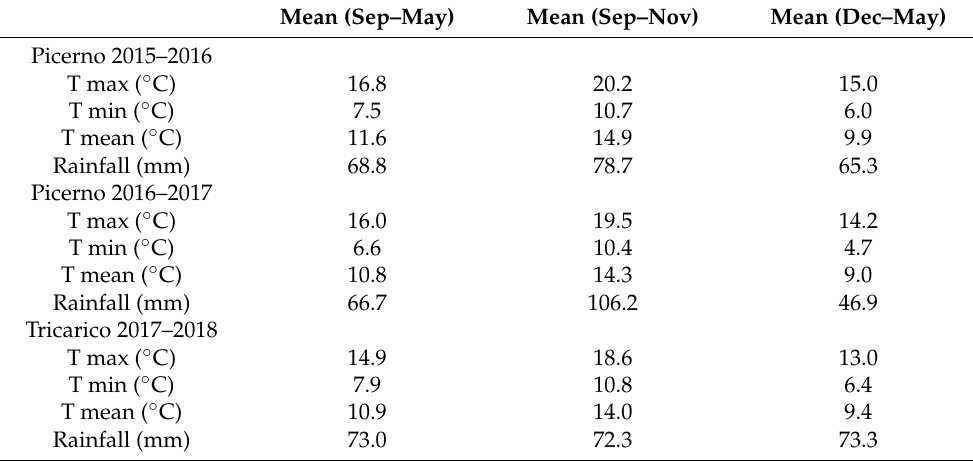
Table 2. Mean values of monthly minimum, mean and maximum air temperature and rainfall in different periods in the three growing seasons 2015/2016 and 2016/2017 in Picerno and 2017–2018 in Tricarico.